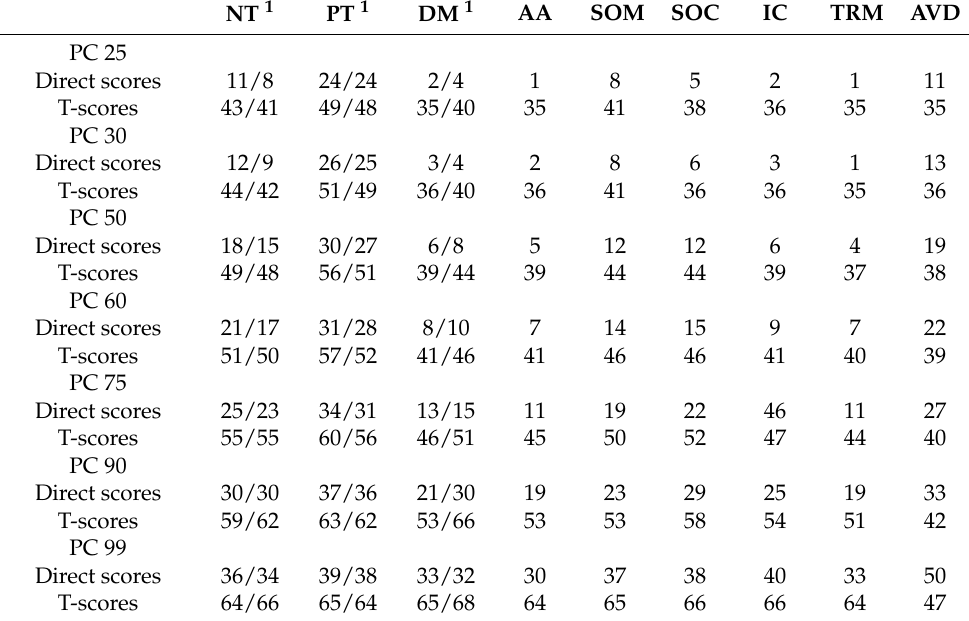
Table 5. Normative data for the MEDI scales.